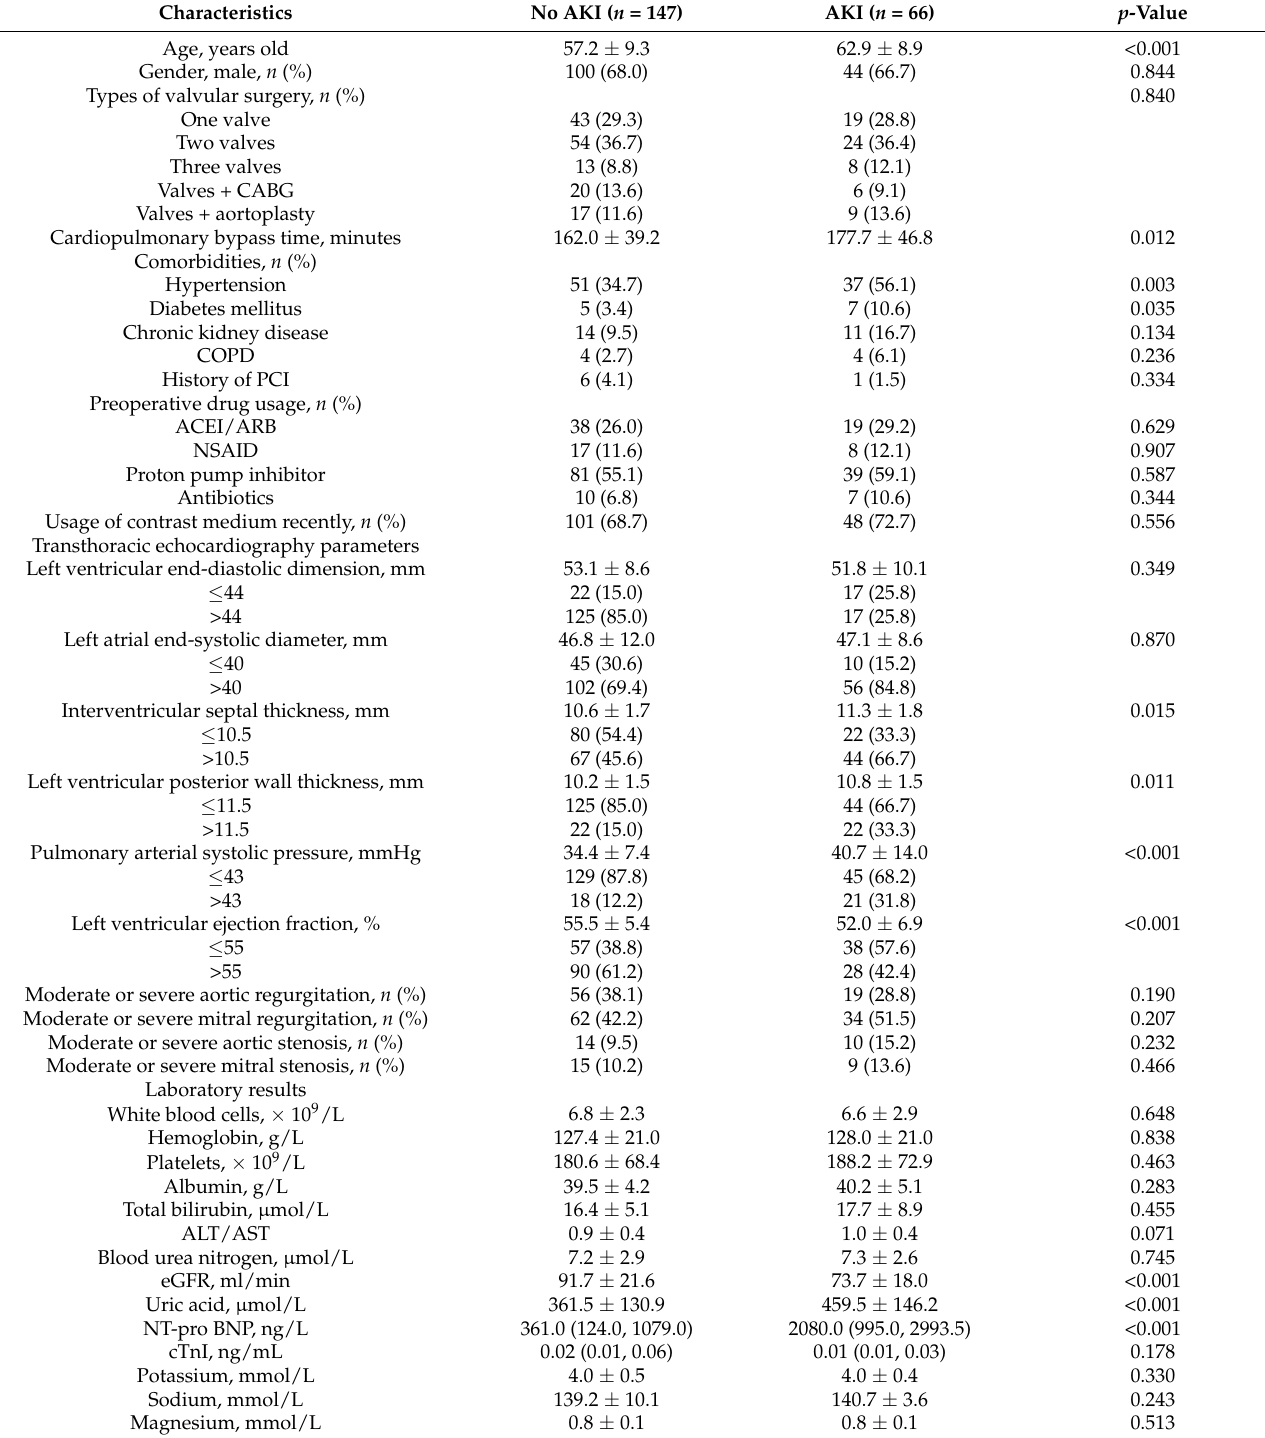
Table 1. Comparisons of characteristics between the no AKI group and AKI